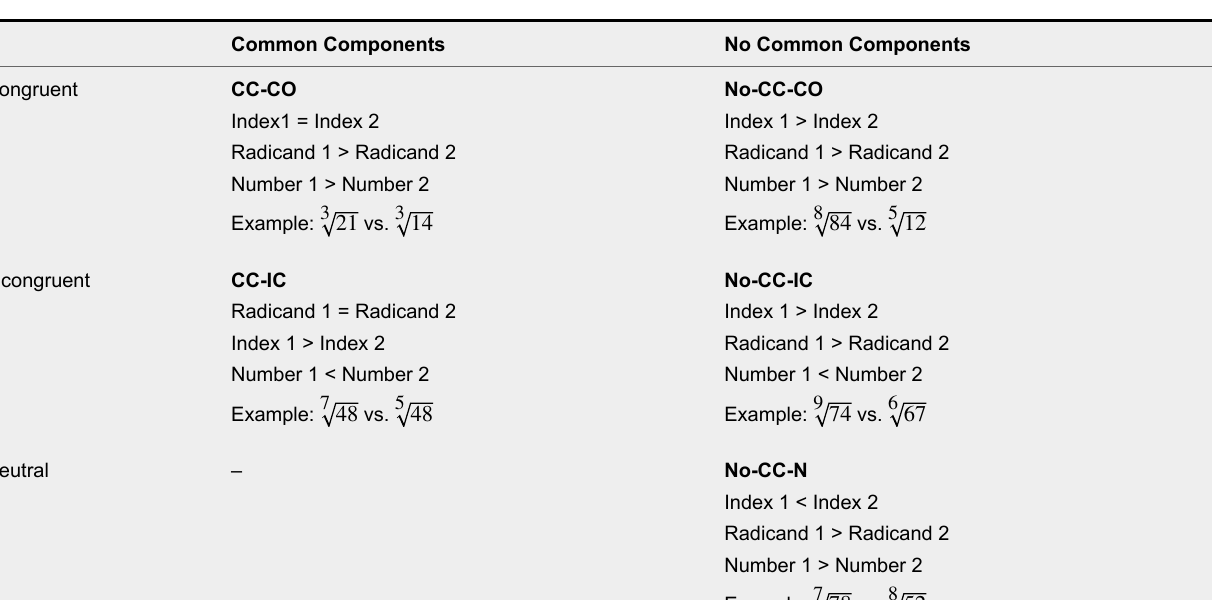
Overview of the Different Problem